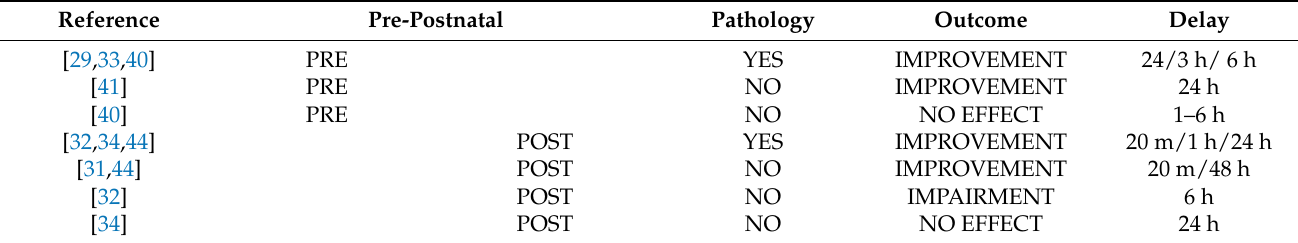
Table 3. Articles that used the object recognition task to assess the dietary choline effect. Prenatal–postnatal supplementation (PRE/POST), animal model of pathology (YES/NO), treatment outcome (improvement/impairment/no effect) and retention delay between the familiarization and testing sessions. Note that the control groups without pathological conditions included in studies using pathological conditions has also been considered. Pathological conditions include chronic animal models of pathologies, acute insult and deficiencies caused by prenatal/postnatal treatments and immaturity.